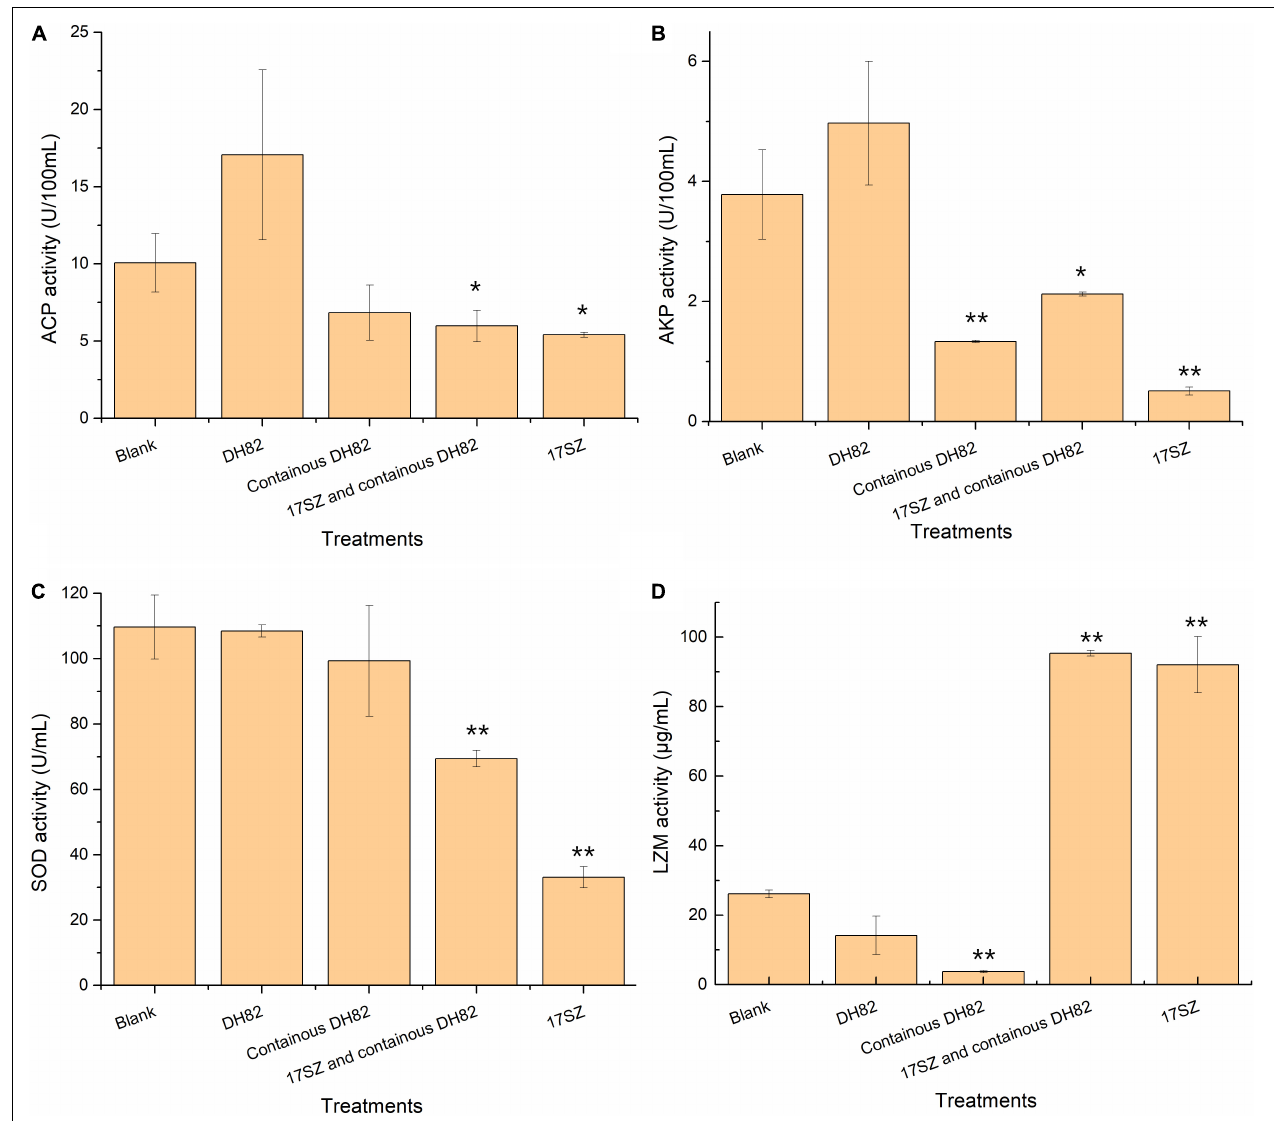
FIGURE 5 | Effect of bacterial treatments to acid phosphatase (ACP), alkaline phosphatase (AKP), superoxide dismutase (SOD), and lysozyme (LZM) activities in the serum of shrimps. Each 100 mL bacterial culture (OD 600nm 0.1) was individually poured into aquaria for bacterial bath challenge to shrimps with final concentration of 10 5 CFU/mL. The enzyme activities of serum under the treatment of blank (negative control), DH82 in the first week, continuous DH82 in each week, 17SZ then continuous with DH82, and the 17SZ only as infection control are presented, panel (A) is ACP, panel (B) is AKP, panel (C) is SOD, and panel (D) is LZM. The error bars are presented as the standard deviation. Statistical analysis results are presented by significant difference that indicated by ** where p < 0.01 and * where p <